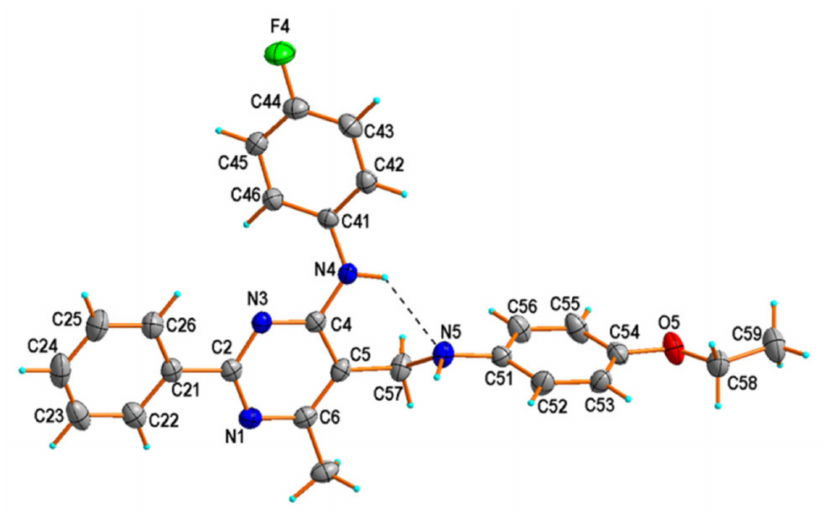
Figure 2. X-ray molecular structure of 2 with the atom-numbering scheme. Displacement ellipsoids are drawn at the 50% probability level. H atoms are shown as small spheres of arbitrary radii. The dashed line (in black) indicates the N–H · · · N hydrogen